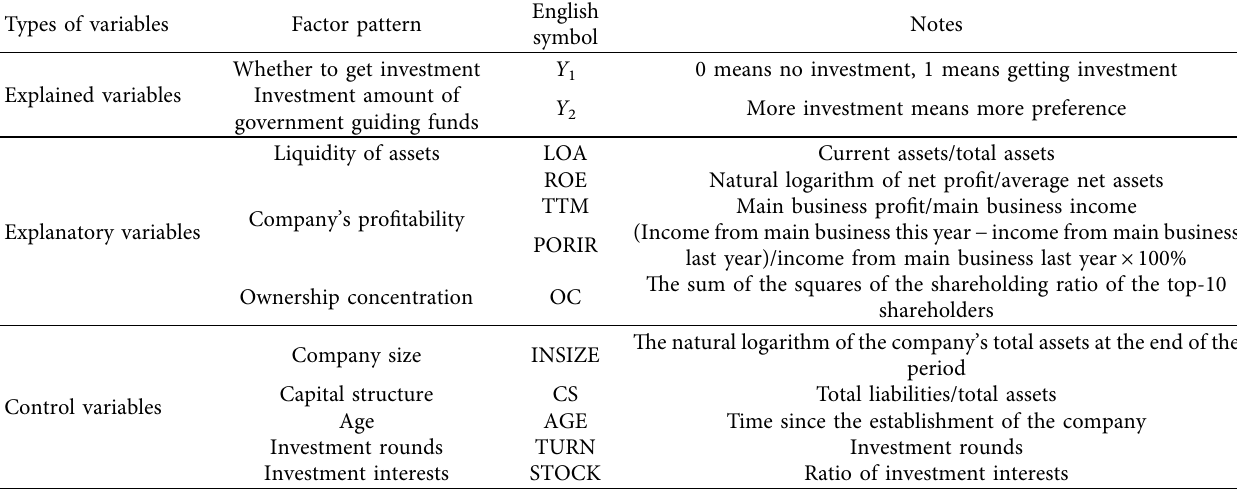
Table 1: Selected variable types and